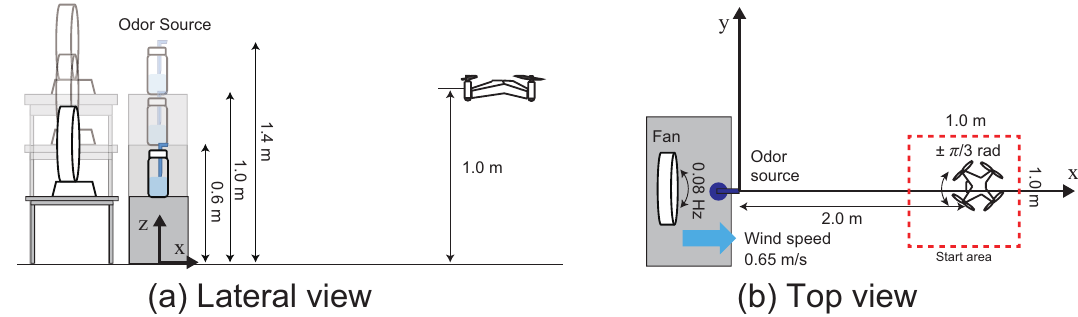
Figure 16. Schematic of the three dimensional CPT experiment field. ( a ) Lateral view; ( b ) top